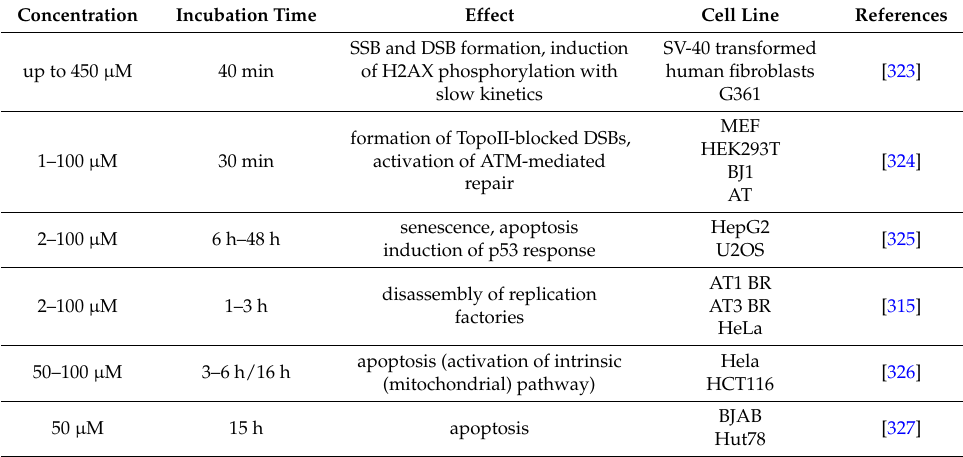
Table 5. Effects of various etoposide treatments in